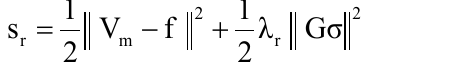
Fig.1: Current injection and voltage measurement in EI T for a closed domain (Ω) surrounded by surface electrodes at the domain boundary ( ∂Ω) (red and blue electrode represent the current and voltage electrodes